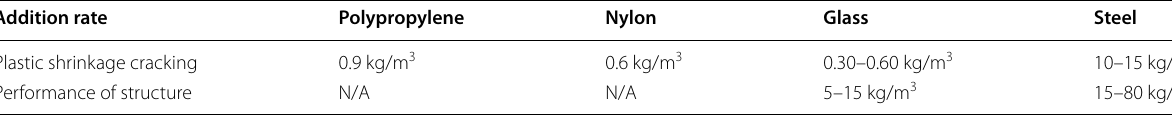
Table 3 Fiber addition rate according to fiber type and manufacturer specifications (Nycon,